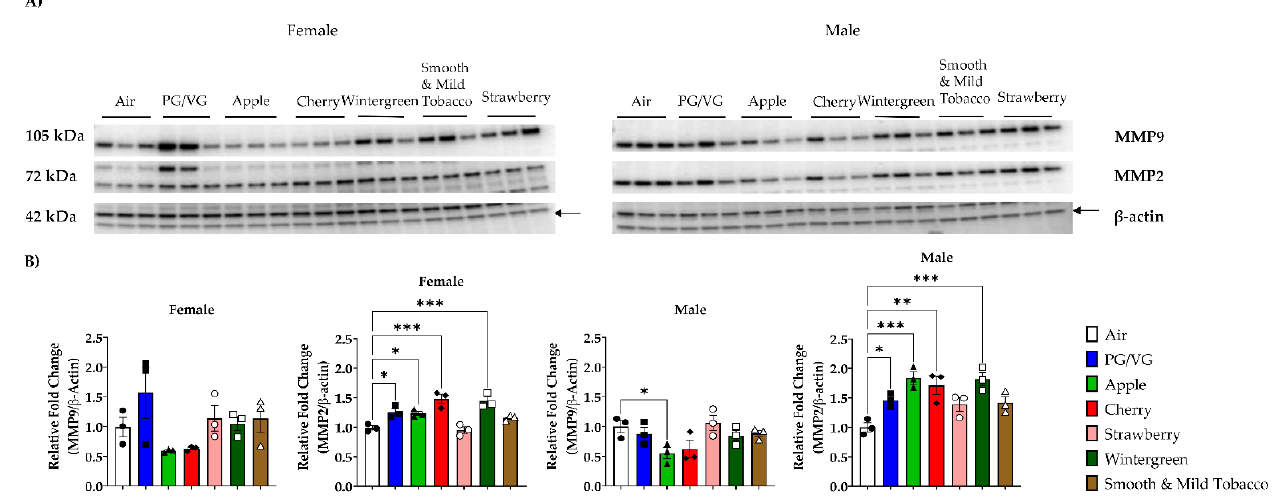
Figure 4. Effects of acute flavored e-cigarette exposure on matrix metalloprotease protein levels in lung homogenate. Mice were exposed to air, PG/VG, and e-liquid flavors “Apple”, “Cherry”, “Strawberry”, “Wintergreen”, and “Smooth & Mild Tobacco” for 3 days for 1 h per day. Mice were sacrificed twenty-four hours after the final exposure. Protein levels for matrix metalloproteinases were measured in lung homogenate using Western blot. ( A ) MMP2 and MMP9 protein abundance in mouse lung homogenate from male and female exposed mice. ( B ) Band intensity was measured using densitometry and data are shown as fold change compared to air control mice. Data are shown as mean ± SEM with individual data points represented by the following symbols: Air (black circles), PG/VG (black squares), Apple (black triangles), Cherry (black diamonds), Strawberry (white circles), Wintergreen (white squares), Smooth & Mild Tobacco (white triangles), with * p < 0.05, ** p < 0.01, and *** p < 0.001 vs air controls. n = 3 for male- and female-only groups.